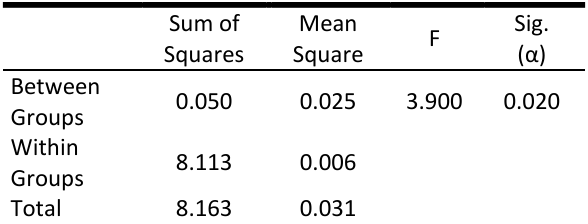
Table 5: The Results of ANOVA for bottom third deformation growth rate Sum of Squares